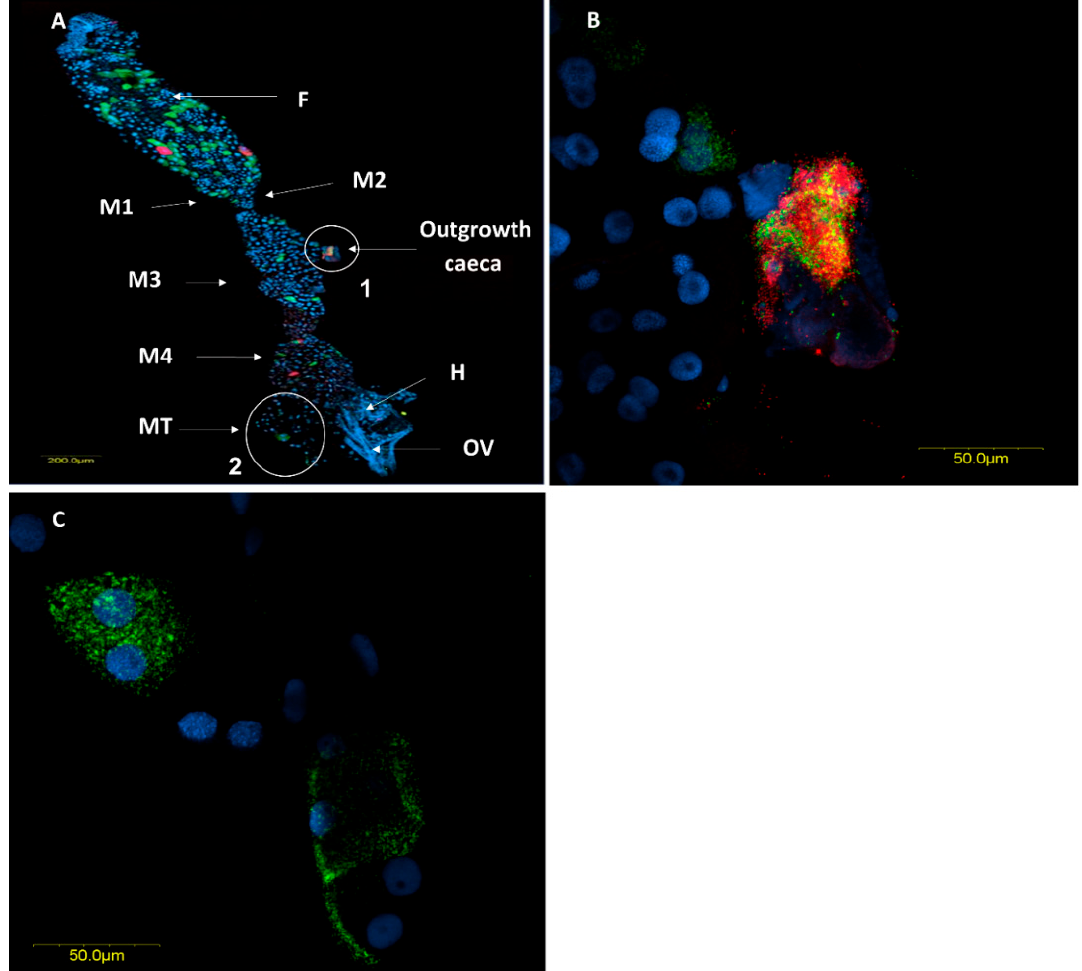
Figure 5. FISH of a female M. pygmaeus digestive system (DNA in blue). ( A ) The whole digestive system, R. bellii (red), R. limoniae (green). Reconstruction: three frames of the same gut; from F to M2 picture number 1, M3 picture number 2, M4 to OV picture number 3. ( B ) Enlarged section of the outgrowth caeca region, in the gut tissue of the third midgut section (white circle 1 in A). ( C ) Enlarged section of Malpighian tubules (white circle 2 in A). Images A number 1, A number 2, A number 3, B and C represent serial Z sections of 20 µm, 55 µm, 50 µm, 12 µm, 17 µm respectively. F, foregut; M1, midgut first section; M2, midgut second section; M3, midgut third section (with outgrowth caeca); M4, midgut fourth section; MT, Malpighian tubules; H, hindgut; OV, ovipositor.